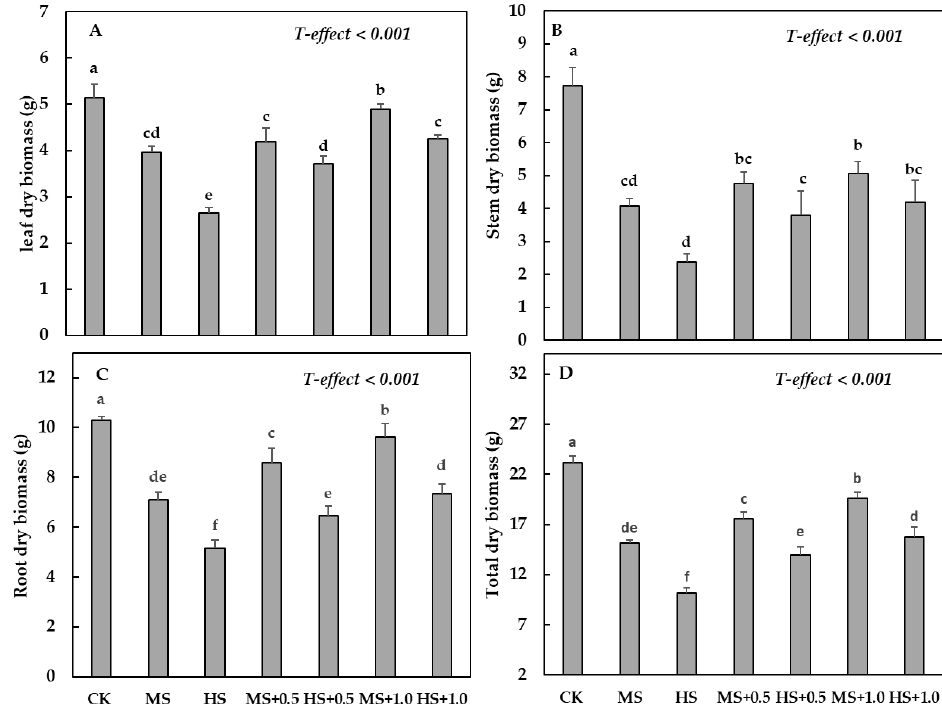
Figure 1. Mean leaf dry biomass ( A ), stem dry biomass ( B ), root dry biomass ( C ) and total dry biomass ( D ) under MS, HS, MS + 0.5, HS + 0.5, MS + 1.0 and HS + 1.0. in M. alba saplings. Small letters represent the significant differences between treatment means (T-effect) at p < 0.05.